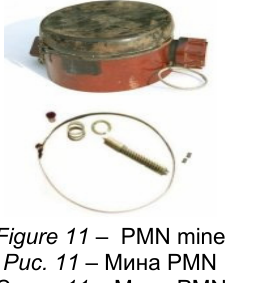
Figure 11 – PMN mine Рис . 11 – Мина PMN Слика 11 – Мина